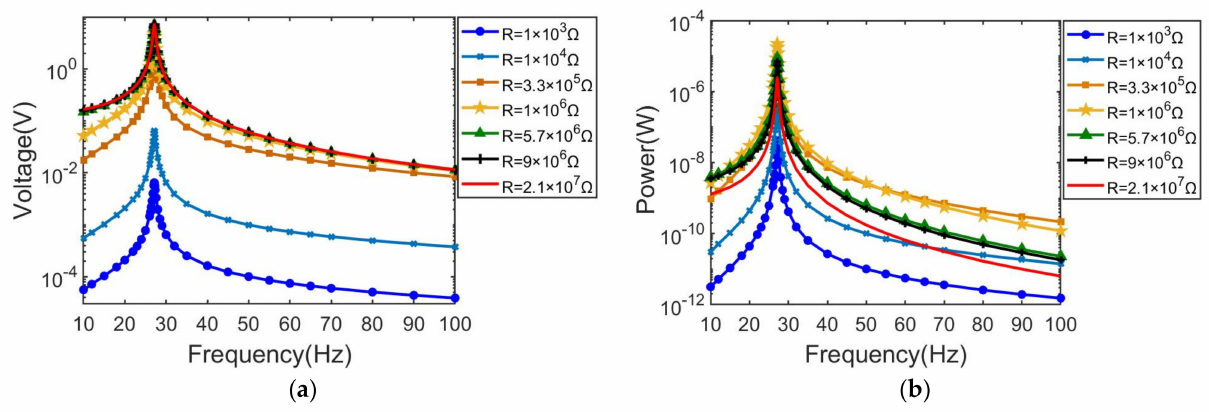
Figure 7. Simulation results of the effects of excitation frequency. ( a ) output voltage response with different load resistance; ( b ) average power response with different load